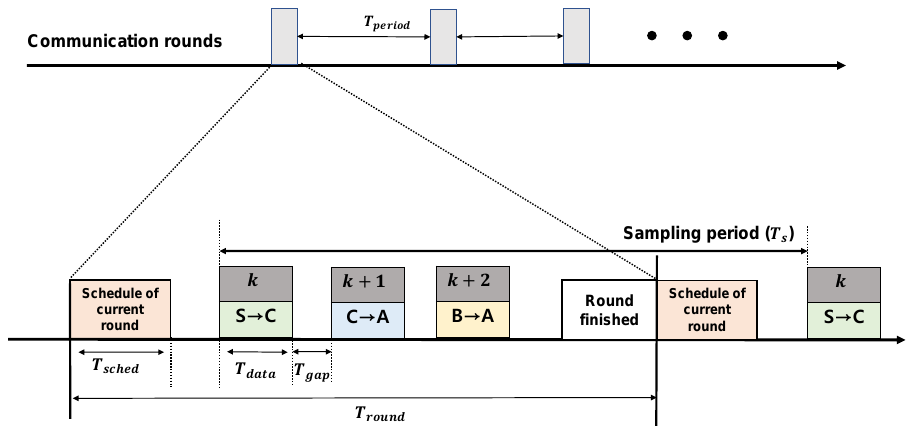
Figure 6. Network scheduling with controller switching. C, primary controller; S, sensor in a plant; A, actuator in a plant; and B, backup controller.